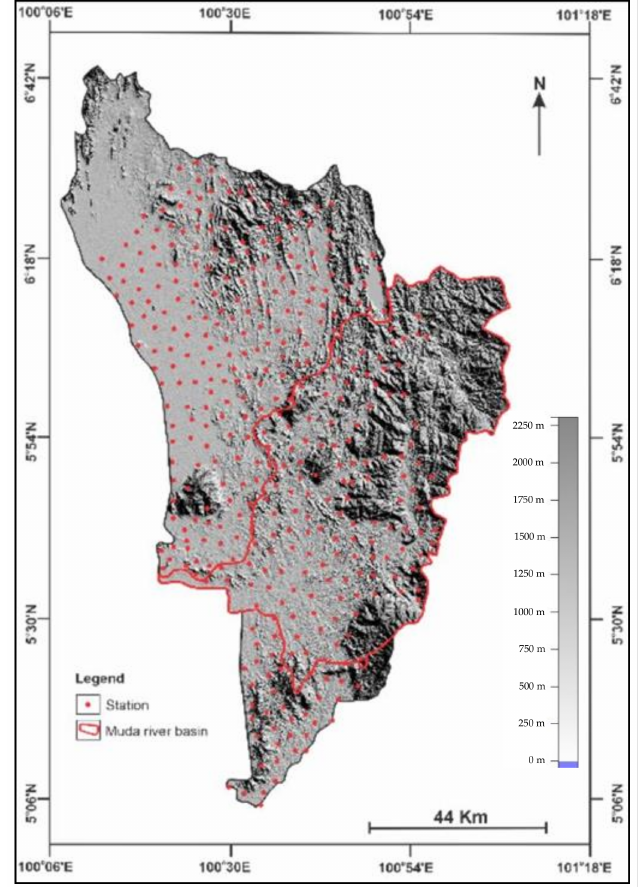
Figure 4. Topography and location map. The eastern part of the study area is dominated by Main Range granite and Bintang Range granite. Due to the extreme topographic region, most of the stations of gravity can only be established on low and flat land.